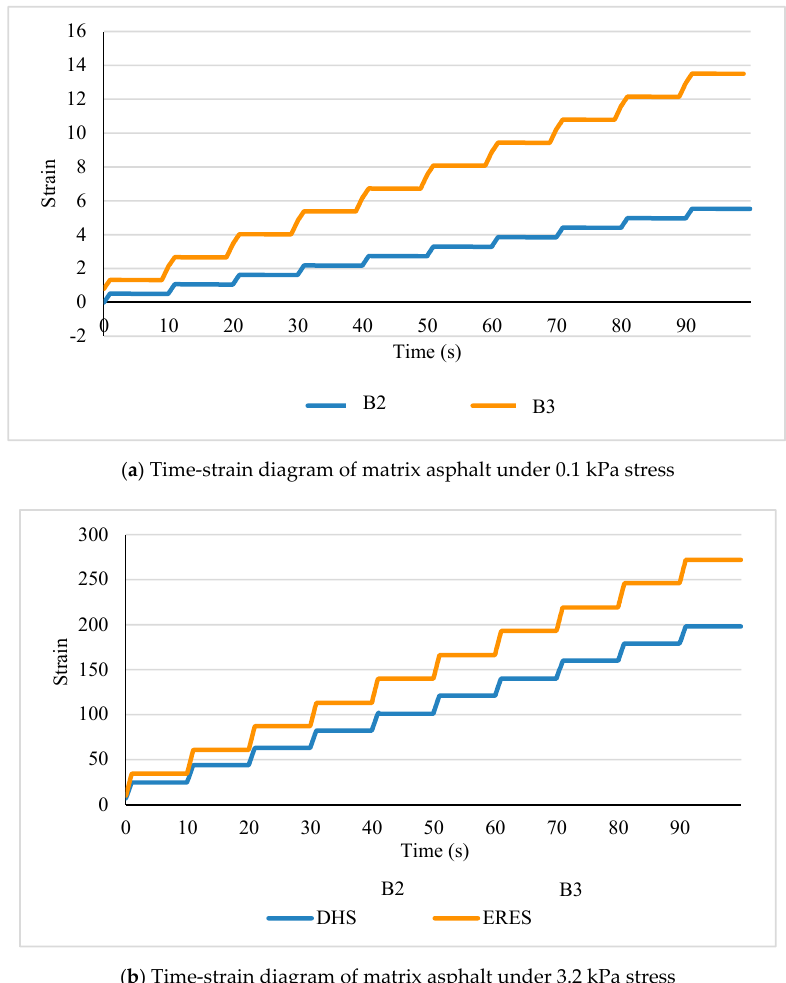
Figure 7. MSCR test results of matrix